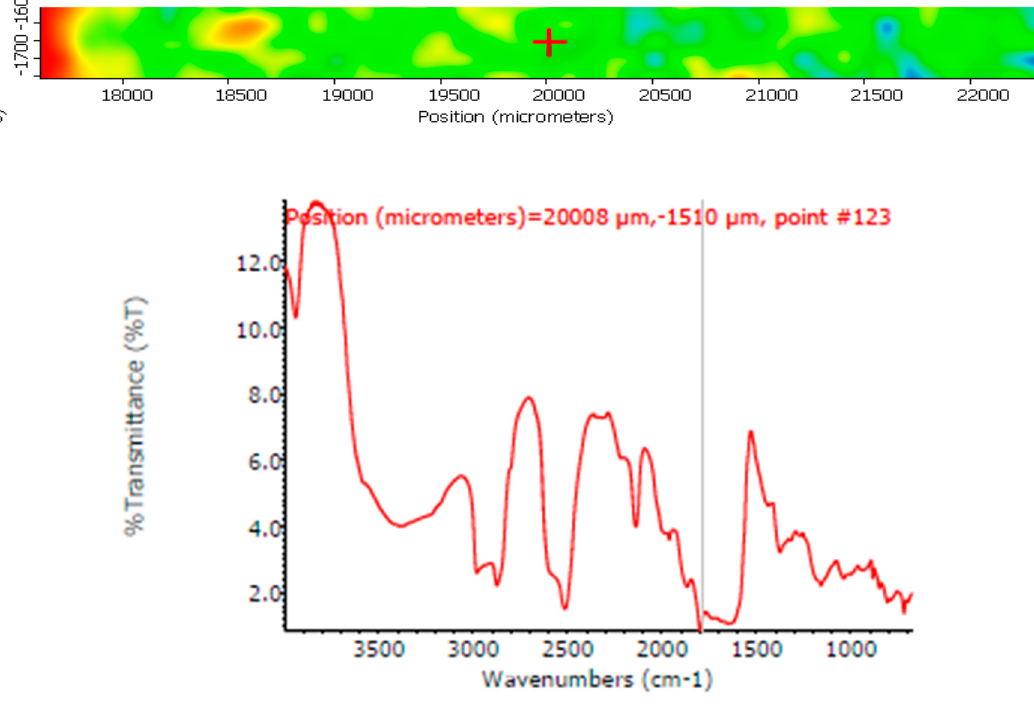
Fig ure 1. Limestone impregnated with the mixing of the COAT O SIL product and